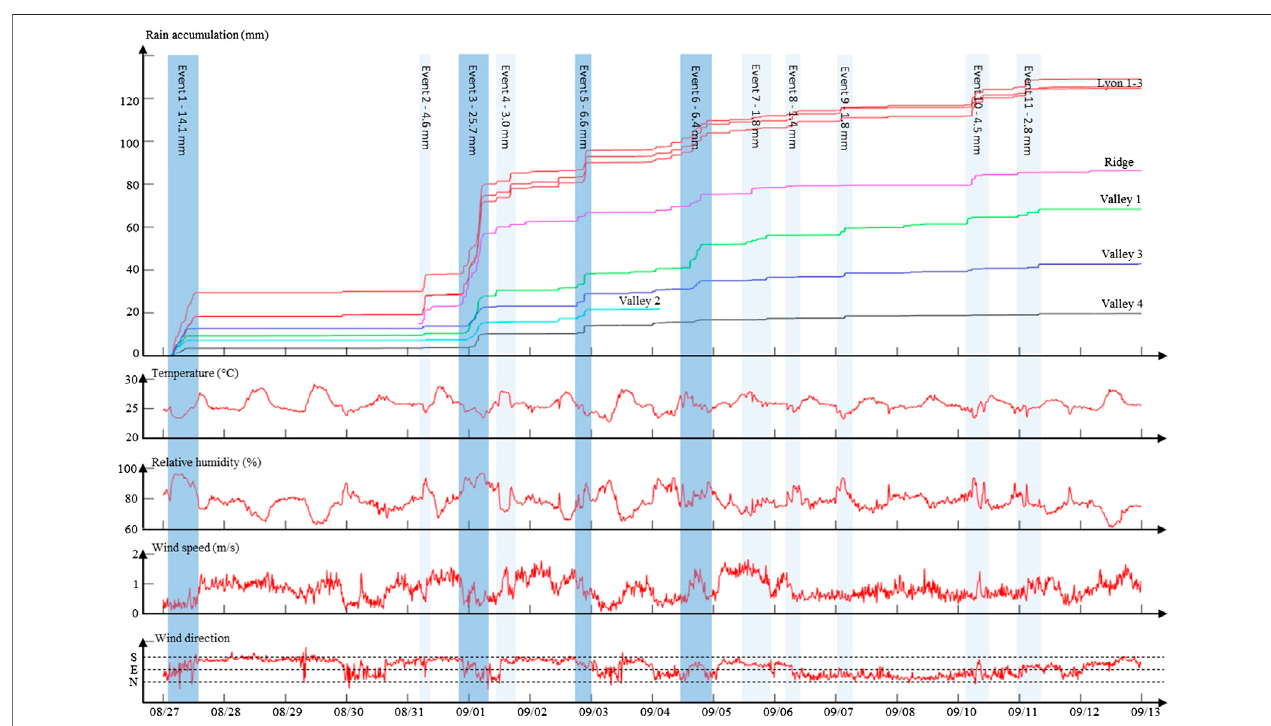
FIGURE3| TimeseriesofrainfallaccumulationobservedbytheeightPluvimatesraingaugesandassociatedweatherconditionsobservedatLyonarboretum.First row: rainfallaccumulation. The color code for gauge identi fi cation is the same asin Figure 2 . Second row: Temperature at 2 m. Third row: Relative humidity. Fourth and fi fth rows: Wind speed and direction (S (cid:2) southerly, E (cid:2) easterly, N (cid:2) northerly). The blue shaded areas identify the rain events; the darker areas identify signi fi cant rain events, i.e. events with mean areal rain accumulation exceeding 5